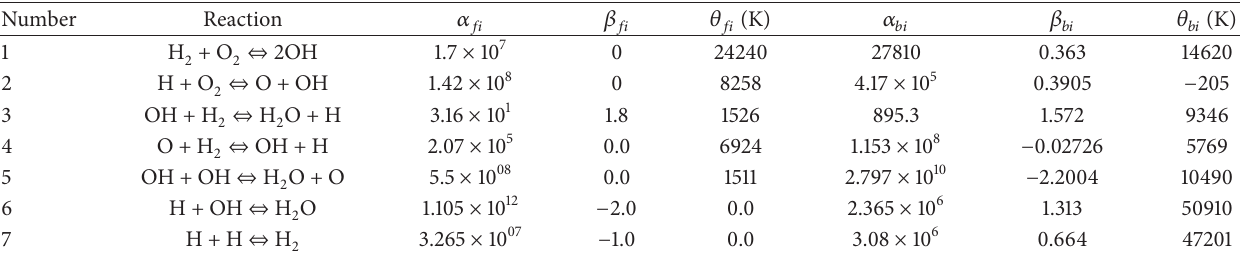
Table 2: Reduced Eklund reaction model [4]. 𝑘 𝑓 in cm 3 /mole ⋅